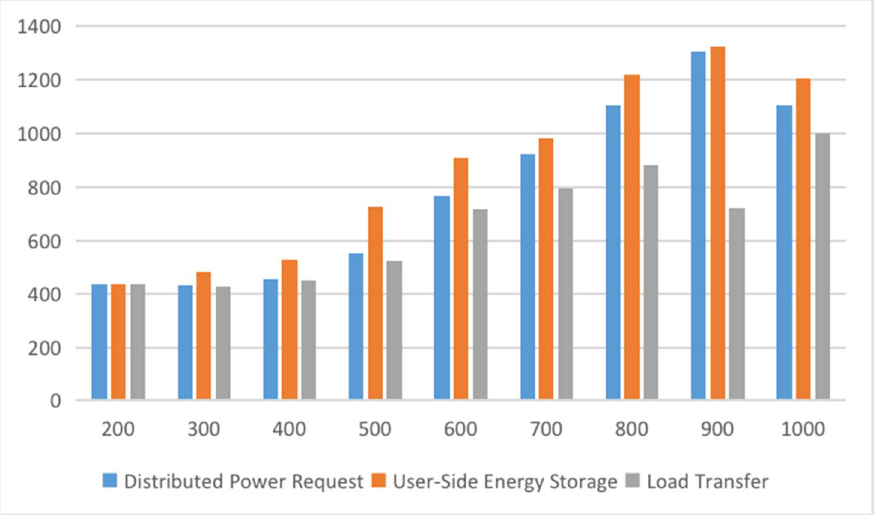
Figure 6. Comparison of average electricity cost of buyer under different methods.